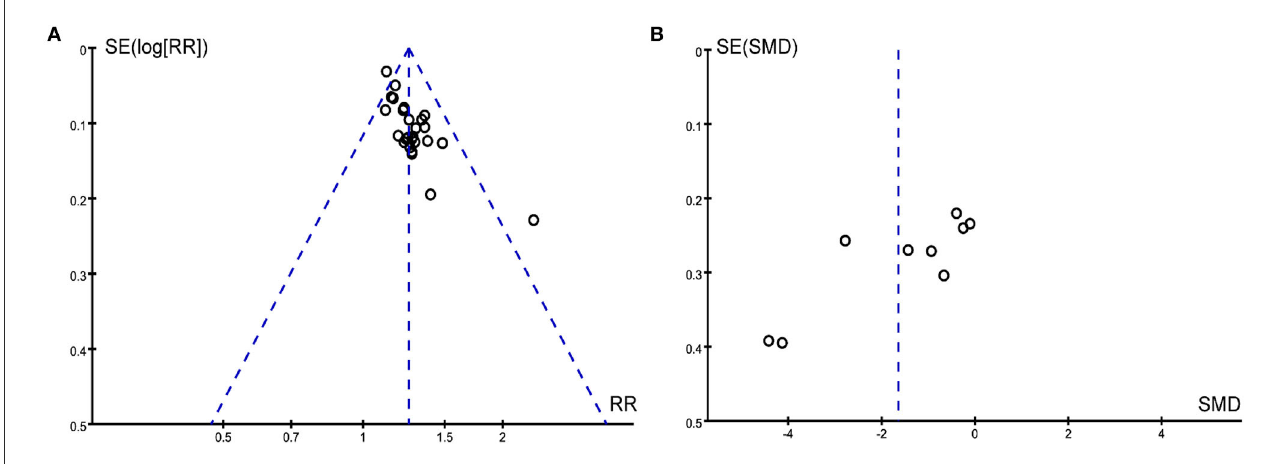
FIGURE8 Funnel plots for (A) the total effective rate and (B) pain